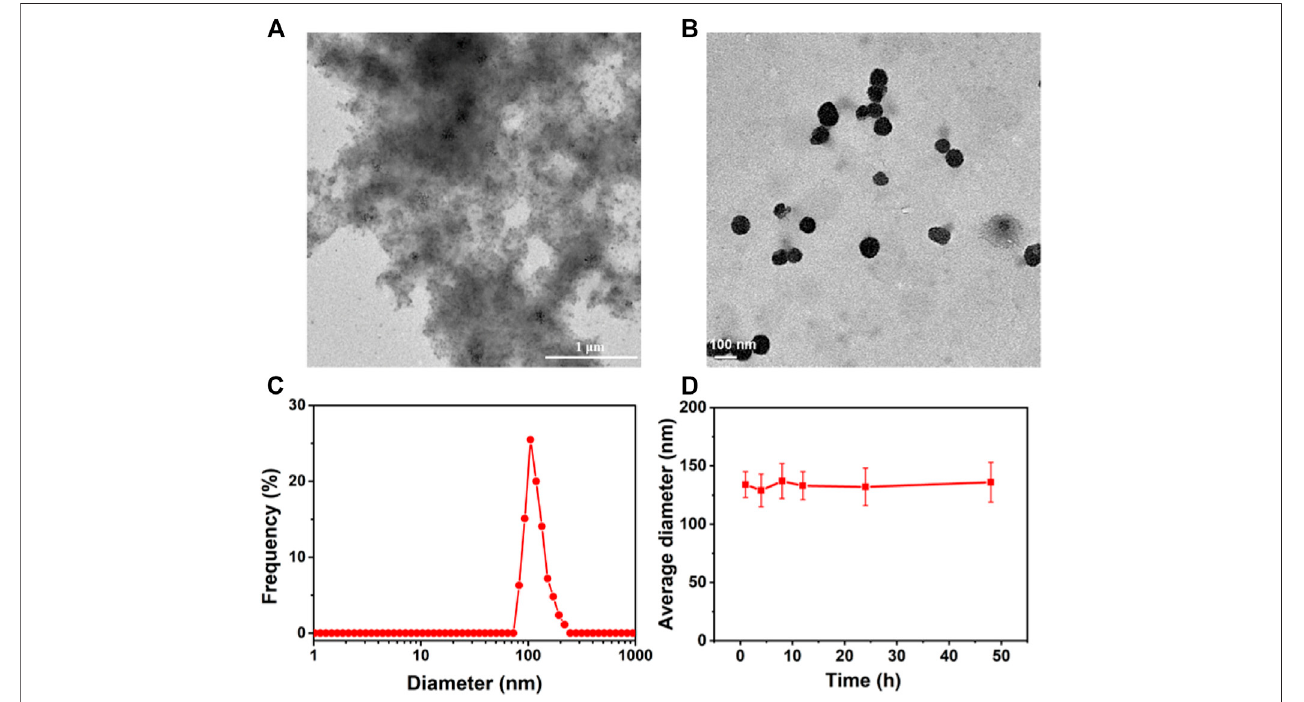
FIGURE 2 | TEM images of aggregates formed from DOX (A) and spherical nanoparticles formed from CB[7] ⊃ DOX (B) , (C) DLS size distributions of nanoparticles self-assembled from CB[7] ⊃ DOX, and (D) diameter changes of nanoparticles formed from CB[7] ⊃ DOX after incubation in PBS for different times.